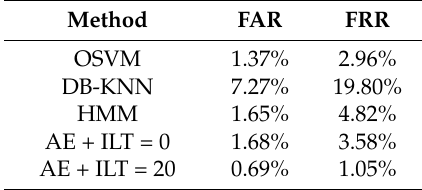
Table 5. FAR and FRR for different methods.